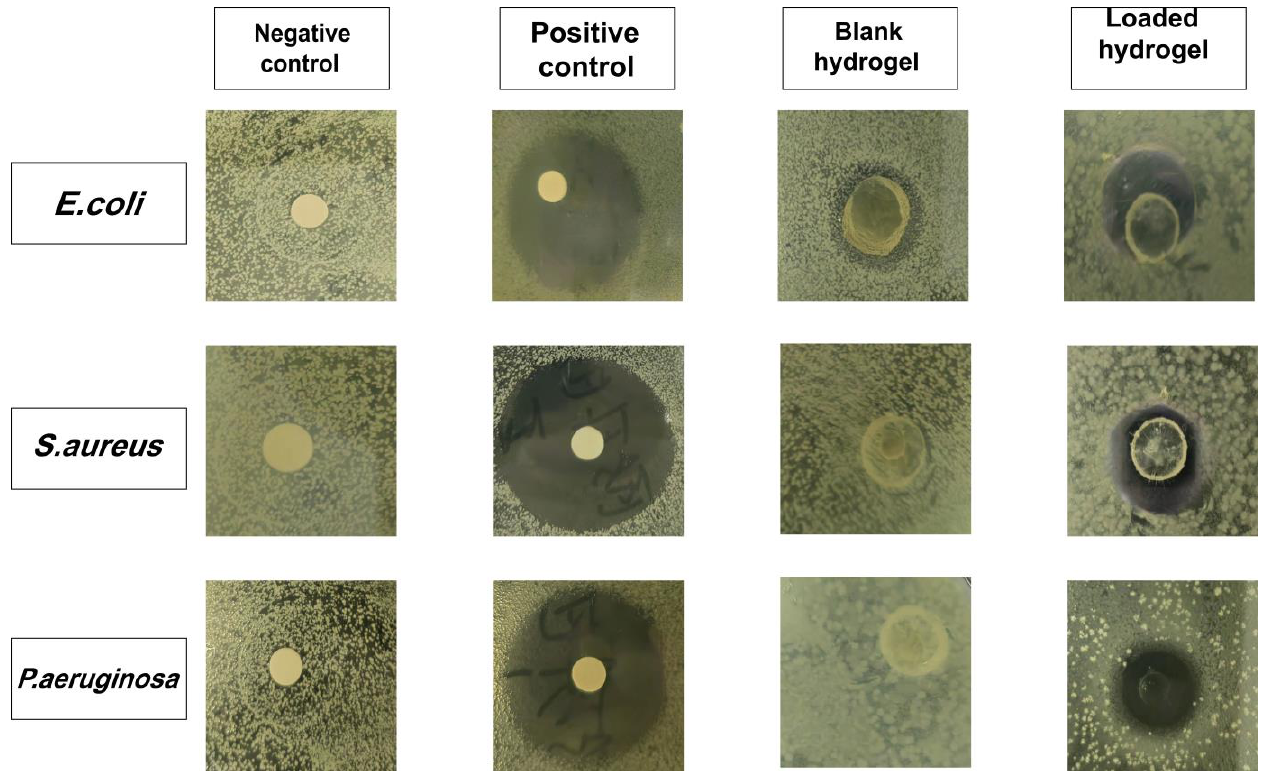
Figure 9. The zones of inhibition for negative control, positive control, unloaded hydrogel and gallic-acid loaded hydrogel membrane against E. coli , S. aureus , and P. aeruginosa.